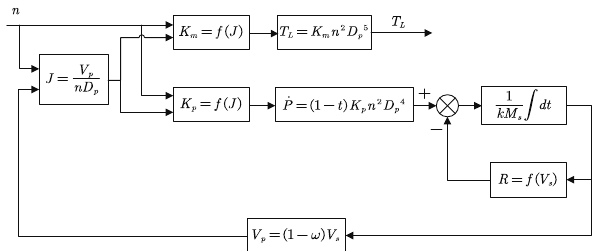
Figure 19. Ship propeller load model.